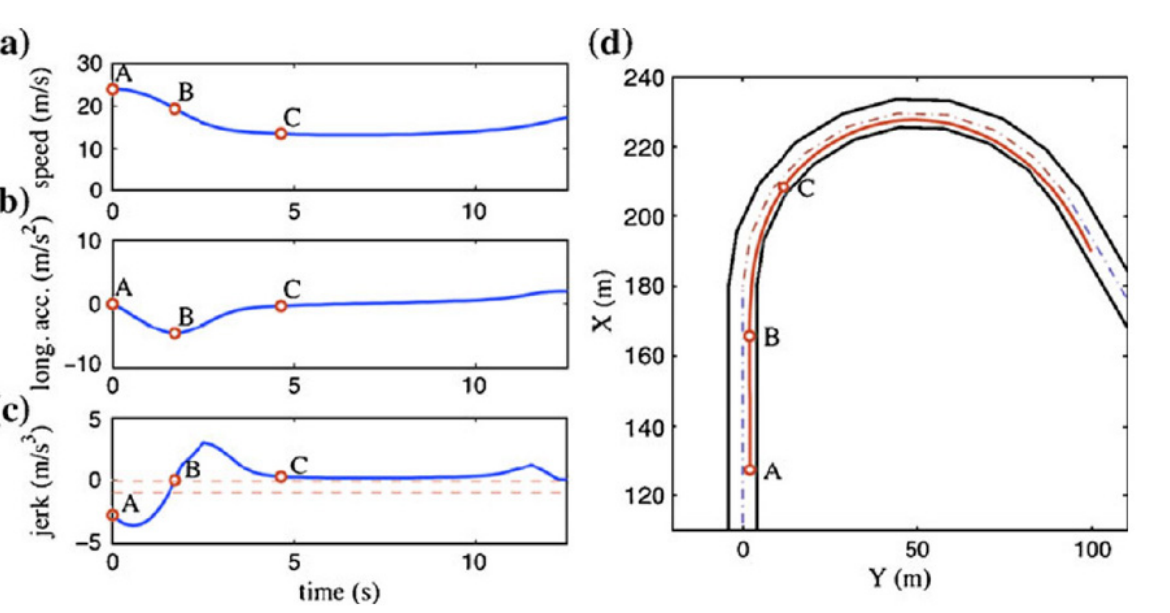
Figure 13. Recommended cinematic quantities in curvilinear trajectory. ( a ) optimal speed profile; ( b ) optimal longitudinal acceleration profile; ( c ) optimal jerk profile; ( d ) optimal